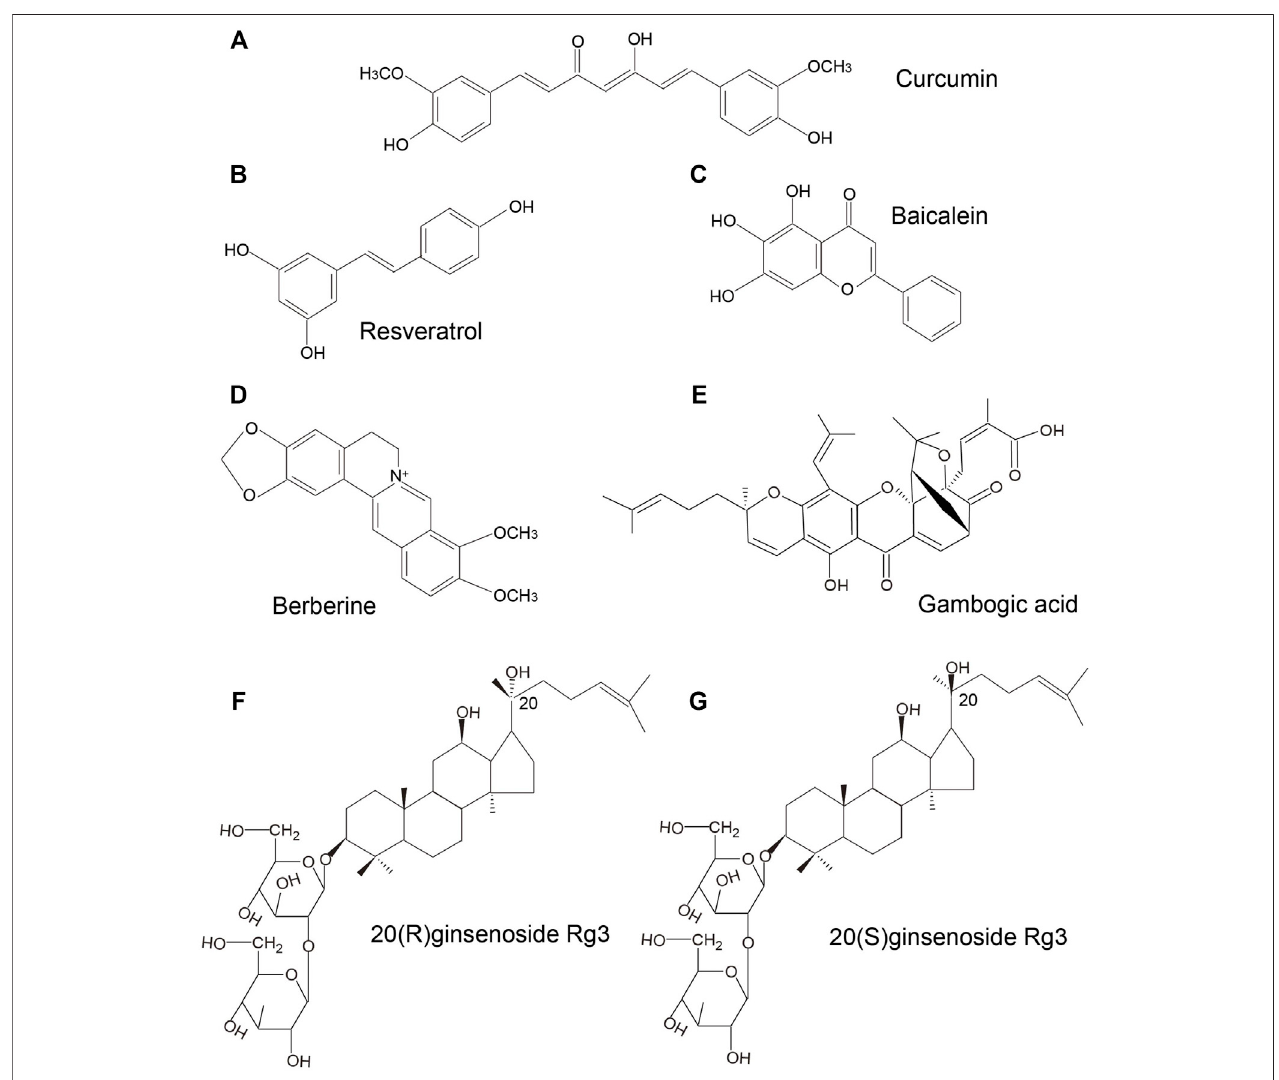
FIGURE 2 | Chemical structures of active components extracted from TCMMs for treaing